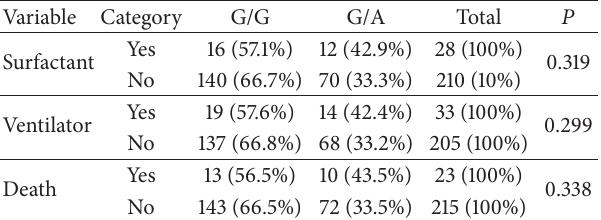
Table 3: Distribution of IL-10-1082 polymorphism, need for mechanical ventilator and surfactant and death in various cate-